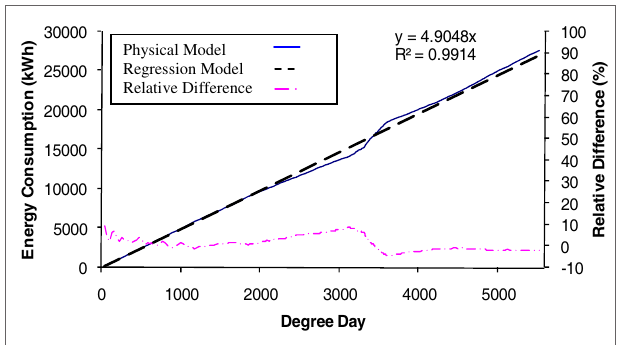
FigUre 9 | regression model derived from the simulation results, case no. 11